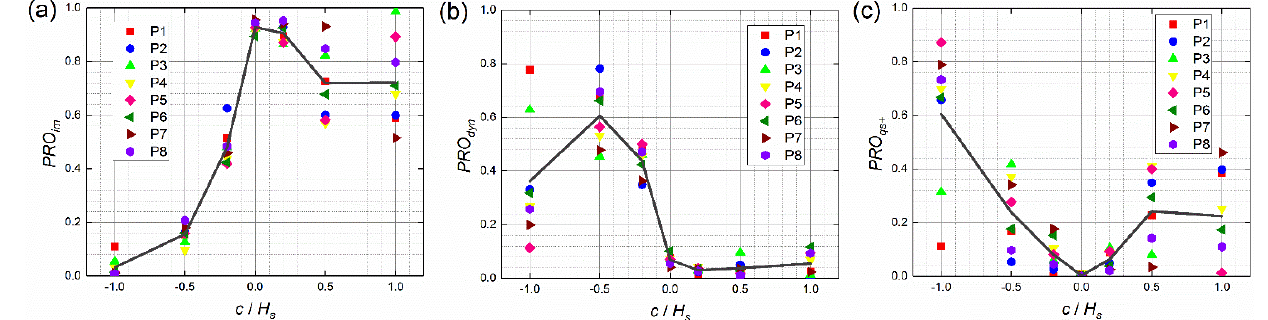
Figure 13. Influence of the relative structural clearance on the probabilities of three types of wave impacts on the horizontal slab portion for incoming significant wave height of 0.10 m (trials T3, T8, T13, T18, T23, T28, and T33): ( a ) impulsive probability PRO im ; ( b ) dynamic probability PRO dyn ; ( c ) quasi-static probability PRO qs+ .